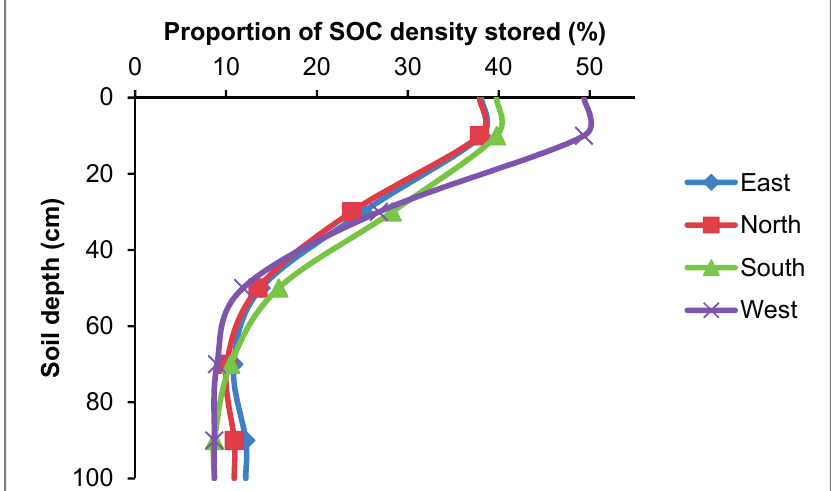
Figure 4. Proportion of SOC density (kg·m − 2 ) stored at different depth intervals under different aspect directions. Data are in percentage and are plotted at the midpoint of each depth